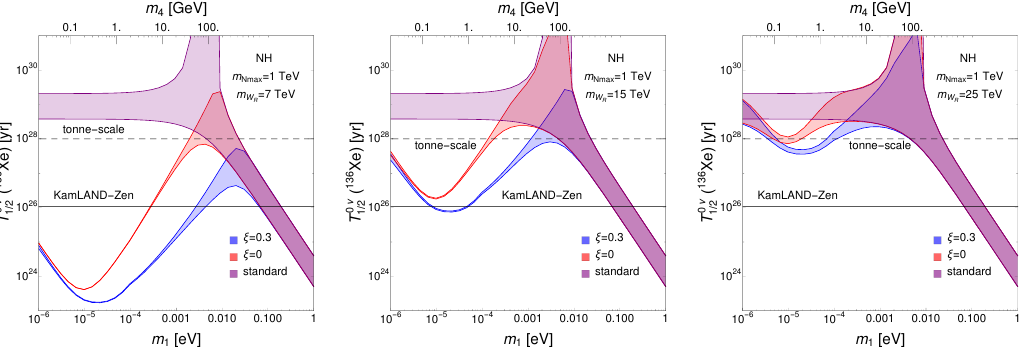
Figure 3. The half-life as a function of the lightest neutrino mass m 1 in the type-II dominance scenario for the NH with m = 1 TeV and m = 7 TeV (left), 15 TeV (middle), 25 TeV (right). N max W R The red and blue regions are obtained with the parameter ξ = 0 and 0.3, respectively. The purple regions correspond to the standard mechanism contributions. The lightest sterile neutrino mass m 4 for given m is shown in the upper frames. The solid and dashed black lines denote the current 1 constraint from the KamLAND-Zen experiment and the expected constraint from tonne-scale experiments, respectively. The uncertainty associated to hadronic and nuclear matrix elements is not